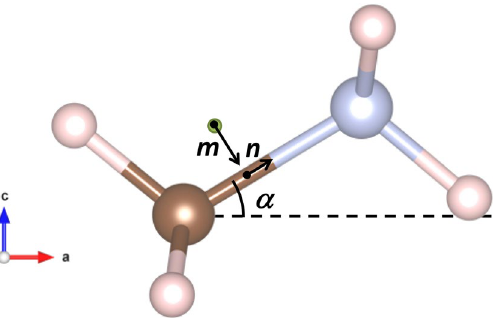
Figure 5. m , n and α parameters that define the configuration of CH 3 NH 3+ organic unit. The green point corresponds to the centre of the perovskite site.